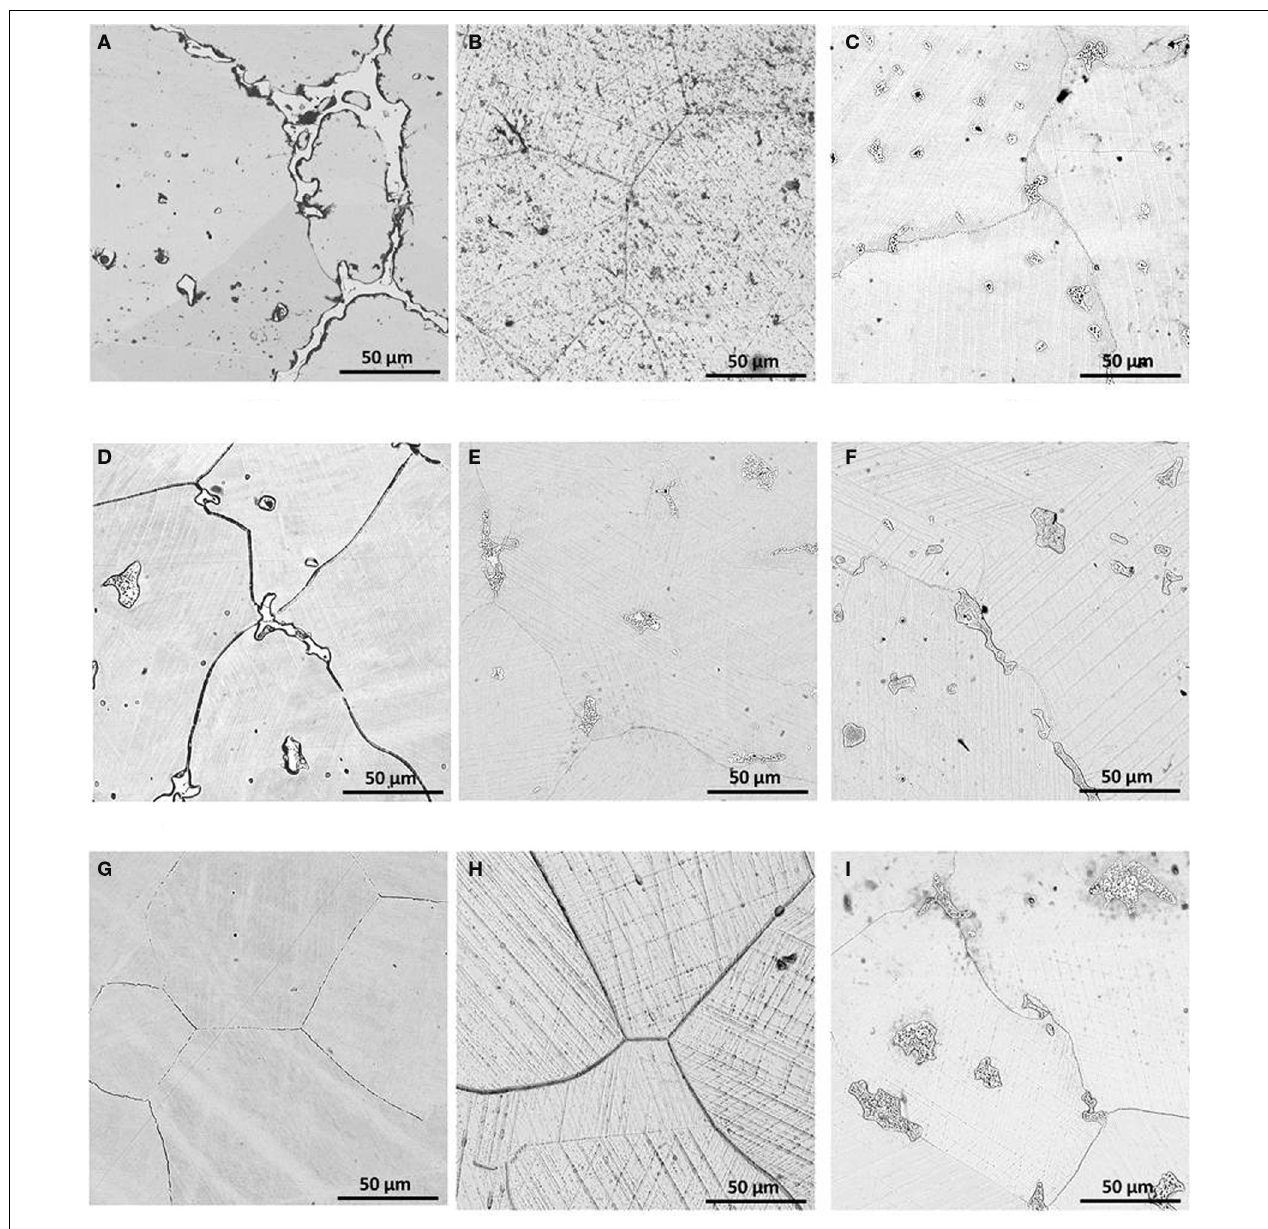
FIGURE 2 | Microstructure of Co-Cr-Mo alloy samples solutionized at 1200° C for different times followed by aging (A) S1-30min, no aging; (B) S2-30min, 815°C, 4h; (C) S3-30min, 830°C, 6h; (D) S4-45min, 830°C, 4h